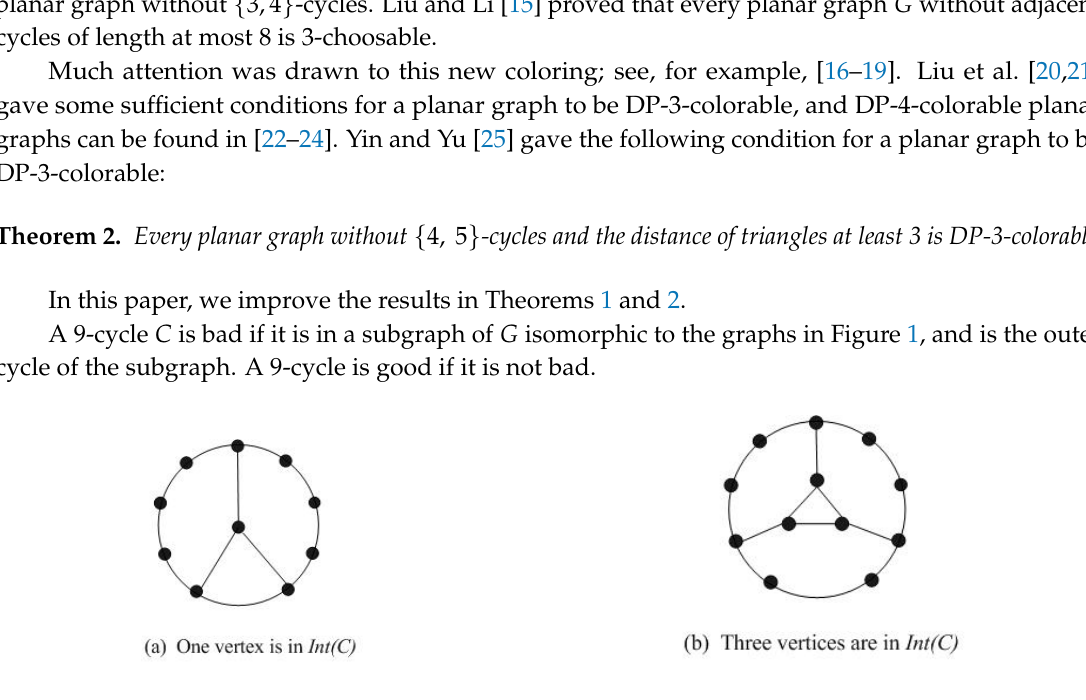
Figure 1. Bad 9-cycles. ( a ) One vertex in Int(C); ( b ) Three vertices in